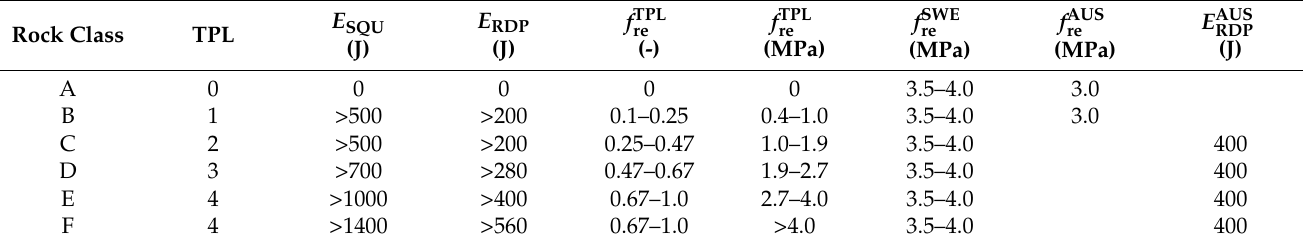
Table 2. Correlation between rock class and energy absorption based on square (SQU) and round panels (RDP) as well as TPL and flexural residual strength; from